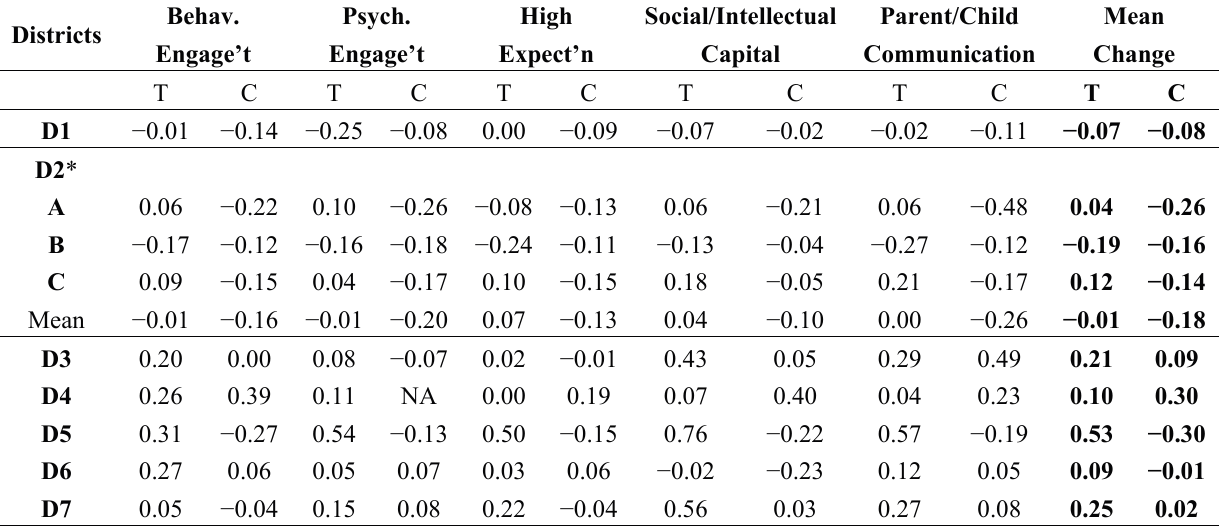
Table 3. Cross-district Summary of Student Survey Results. Mean change scores of treatment (T) and control (C) groups (4 point rating